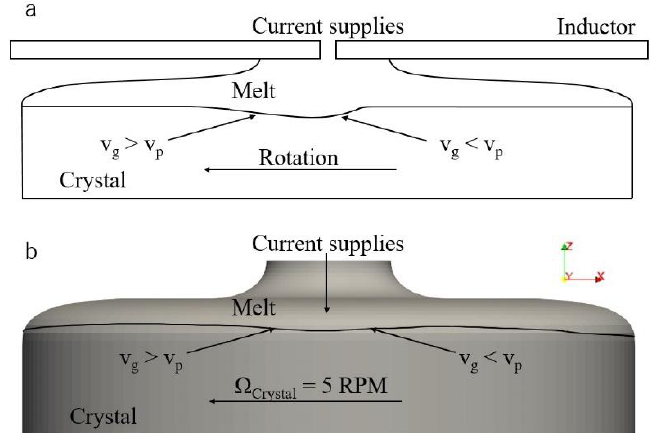
Figure 9. Comparison of the shape of the three-phase line between ( a ) experimental observation results [1] and ( b ) calculation results. The deflection of the three-phase line from the experimental observation result is smaller than that shown in the schematic. The calculated three-phase line exhibits a shape similar to that experimentally observed.